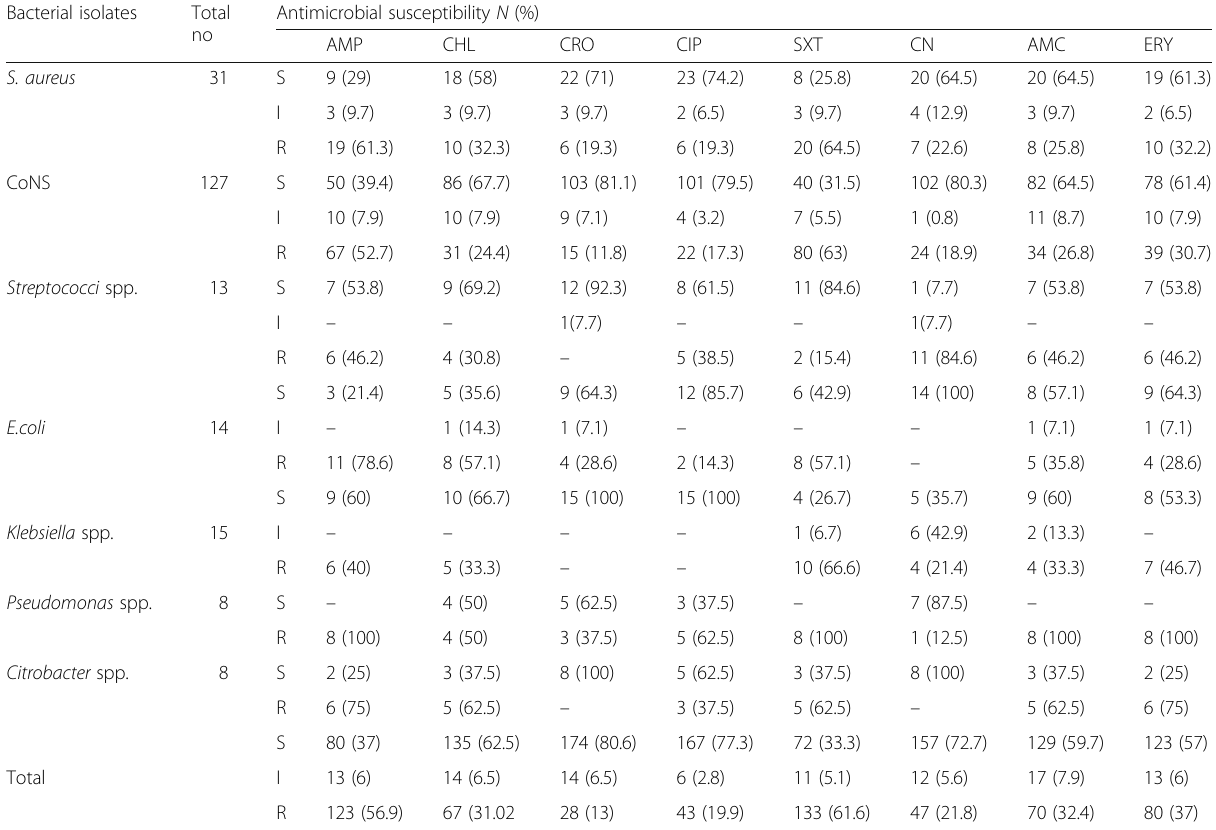
Table 4 Antimicrobial susceptibility pattern of bacterial isolates from the mobile phones of health professionals ( n = 226) at Hiwot Fana Specialized University Hospital, Harar, Eastern Ethiopia, Feb – Mar 2018 Bacterial isolates Total